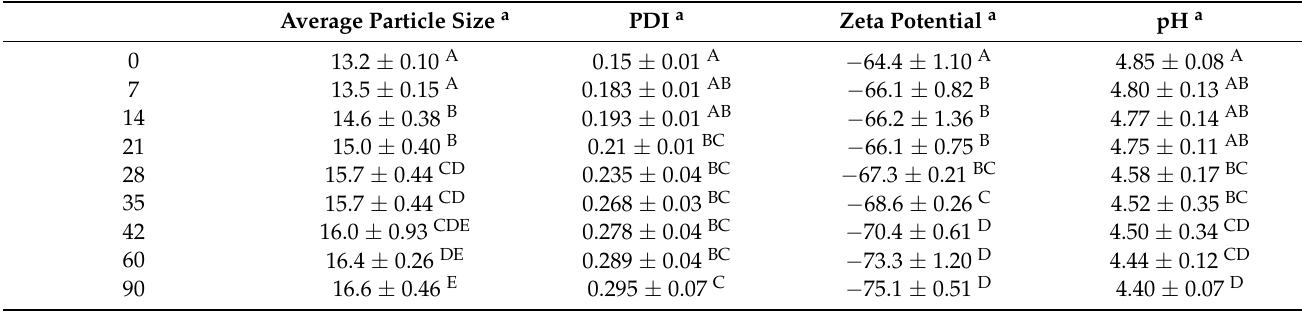
Figure 2. The appearance of chlorophyll nanoemulsion ( A ) and its particle size distribution as determined by a dynamic light scattering instrument ( B ) as well as the transmission electron micrograph imaged at 120 kVa ( C ). Table 2. Particle size, polydispersity index (PDI), zeta potential and pH of chlorophyll nanoemulsion during storage at 4 °C for 90 days.